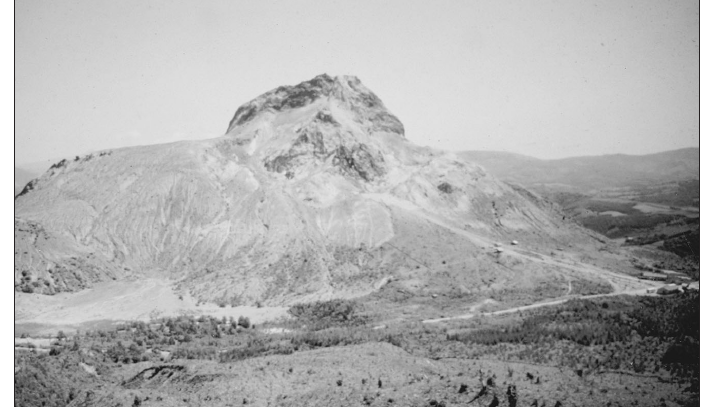
Photo 3. The 1944 Usu lava dome and mound (Showa-shinzan) seen from the eastern summit rim of Usu vol- cano, as of 1958. The relative height of the summit is ca. 300 m on this side. The left-hand low hill preexists, indicated by M in fig.